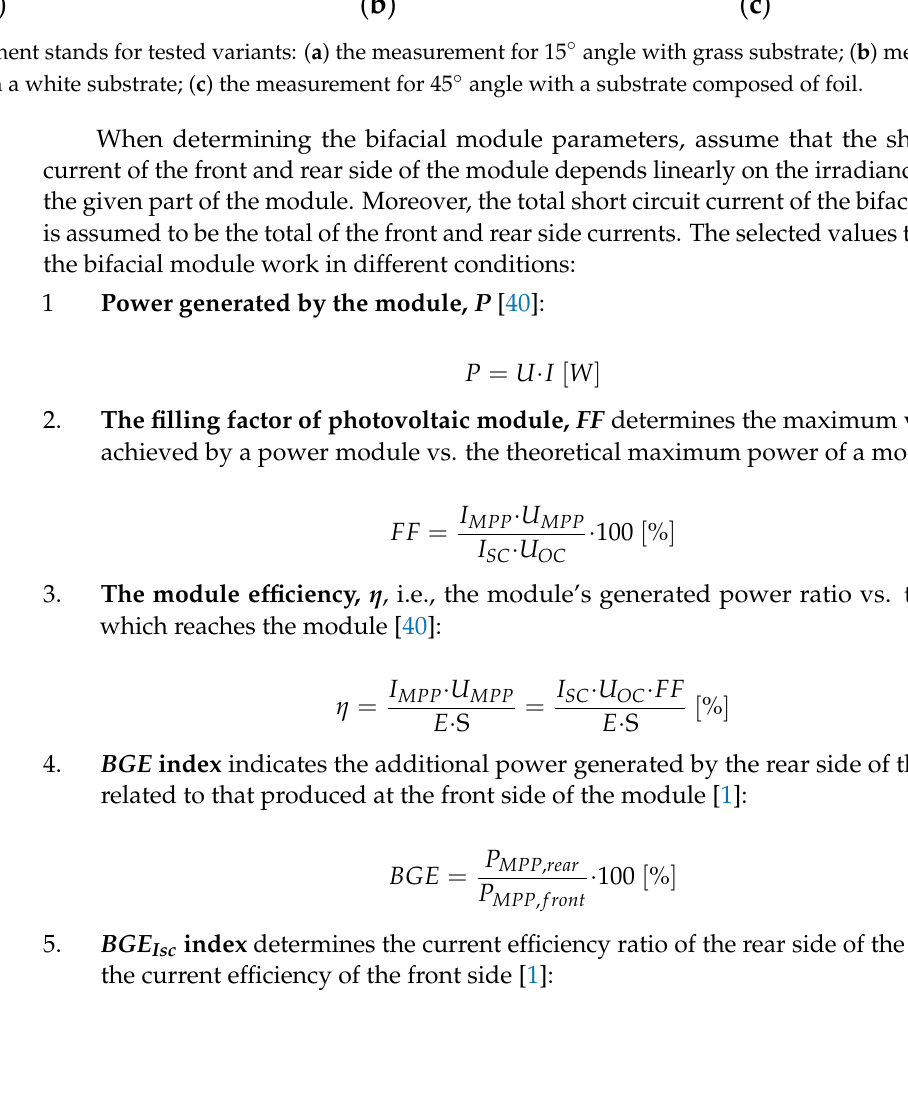
Figure 6. The measurement stands for tested variants: ( a ) the measurement for 15° angle with grass substrate; ( b ) measurement for 75° angle with a white substrate; ( c ) the measurement for 45° angle with a substrate composed of foil.